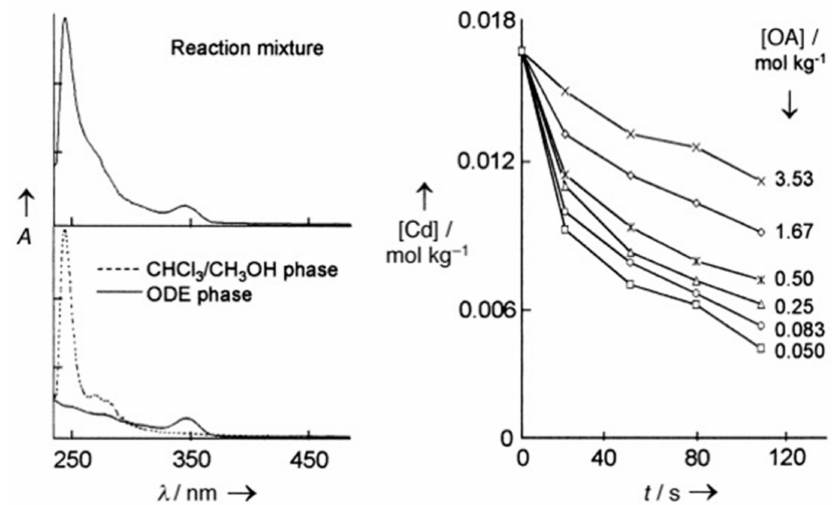
Figure 2. Absorption spectra for the separation of CdS nanocrystals from cadmium oleate and oleic acid. Reprinted with permission from [40]. Copyright 2002, John Wiley &